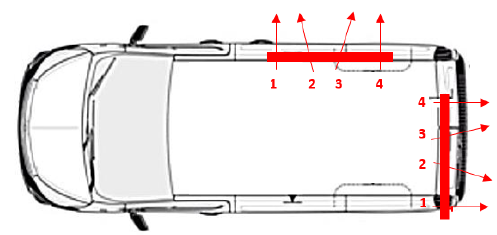
Fig. 10: Position of the cameras on mobile device